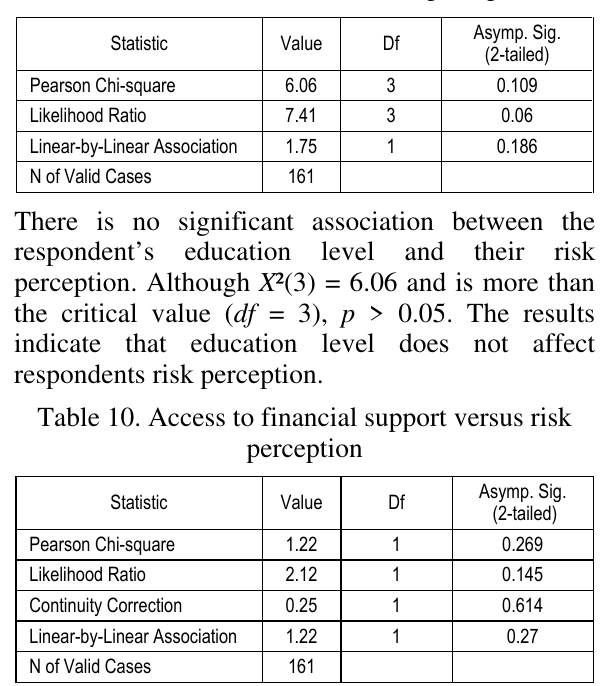
Table 9. Education level vs. risk perception